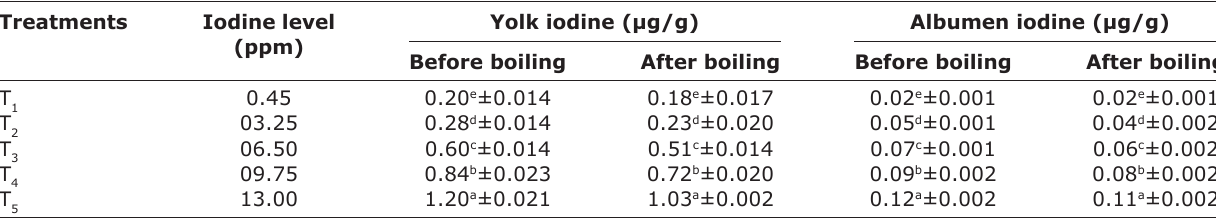
Mean values bearing different superscript differ significantly (p<0.05) Table-3: Concentration of iodine in eggs of laying hens fed on various levels of iodine after 10 th week of supplementation (before and after boiling).